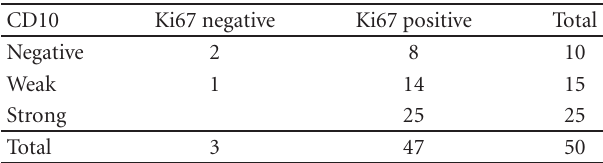
Table 5: Correlation of CD10 with